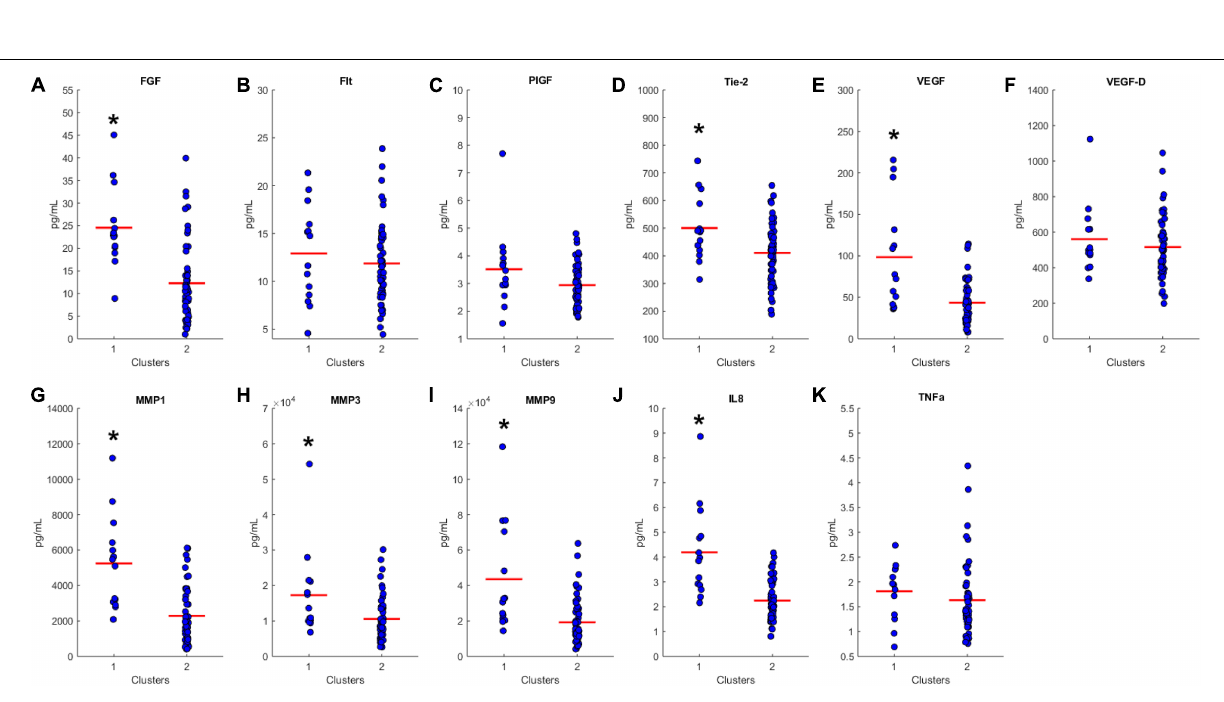
FIGURE 3 | T-SNE dimensionality reduction plot of clustered data. Data were clustered using the Euclidean distance model (A) and the Combined HCA model (B) . The dataset was produced by measuring 11 inflammatory (MMP1, MMP3, MMP9, IL8, TNF α ) and angiogenic proteins of interest (FGF, FLT, PIGF, Tie-2, VEGF, VEGF-D) from 66 participant plasma